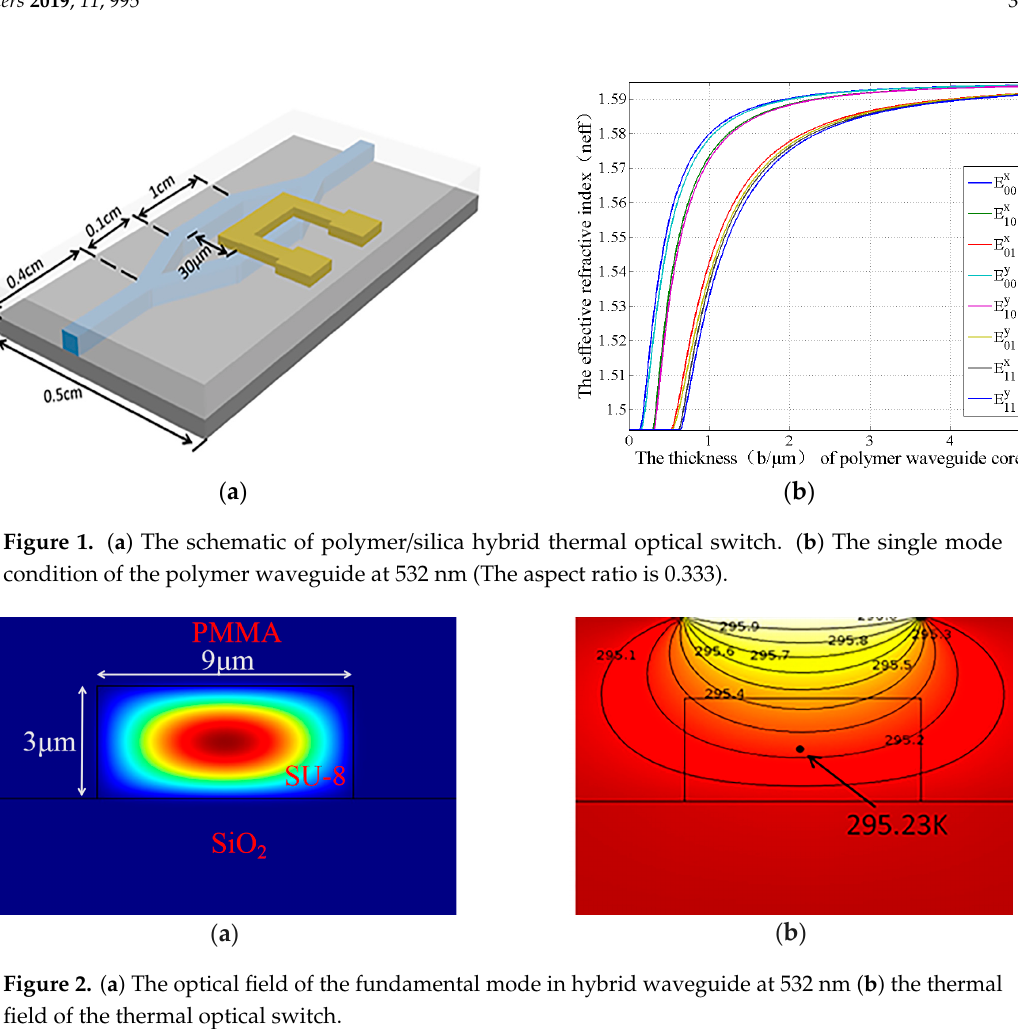
Figure 2. ( a ) The optical field of the fundamental mode in hybrid waveguide at 532 nm ( b ) the thermal field of the thermal optical switch.